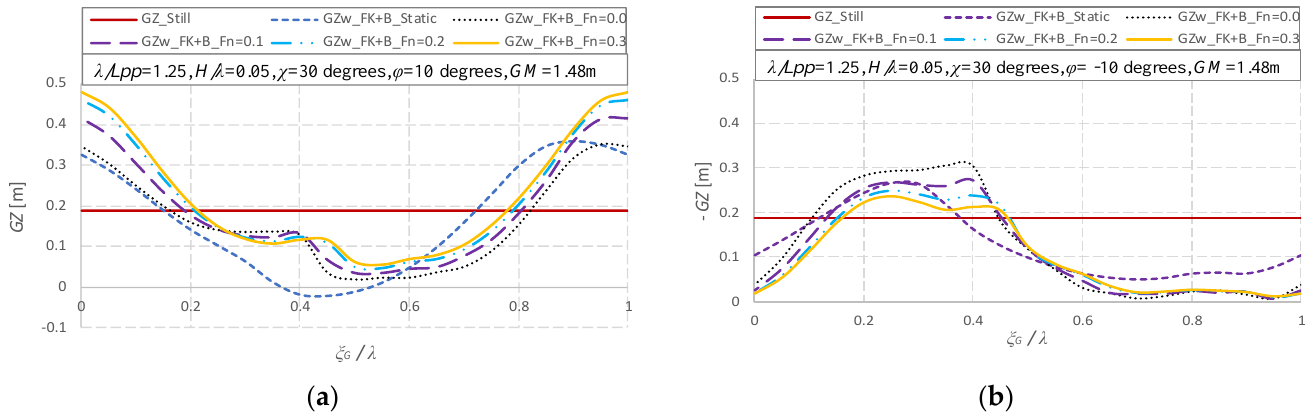
Figure 2. Roll-restoring arm with φ = 10 degrees, ( a ) starboard; ( b ) port.